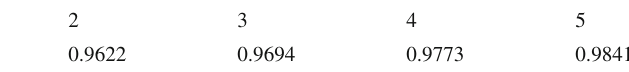
index l . One finds that the characteristic resonant frequency (cid:16) min ( l ) of the composed star–field system is a monotonically increasing function of the angular harmonic index l . As a consistency check, we note